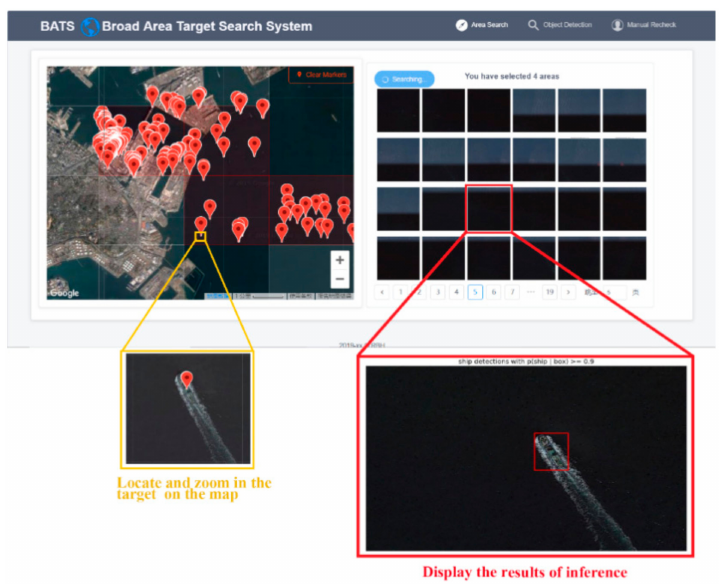
Figure 11. The interface of the broad area search module.